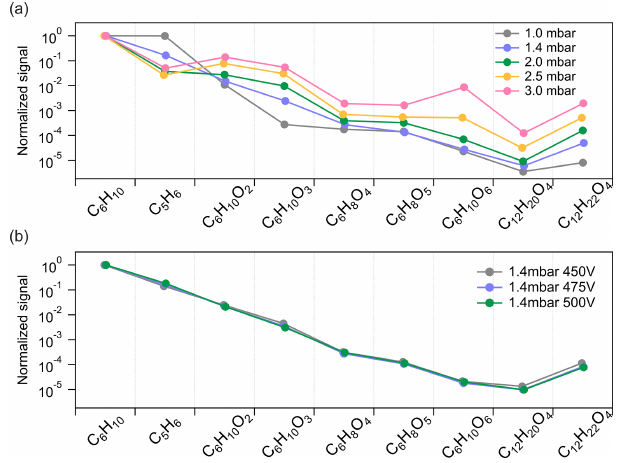
Figure 4. Influence of instrumental settings on the detection of cy- clohexene oxidation products by (a) varying FIMR pressures and (b) varying FIMR DC voltages. The y axis is the signal intensity of different compounds normalized to that of cyclohexene at each